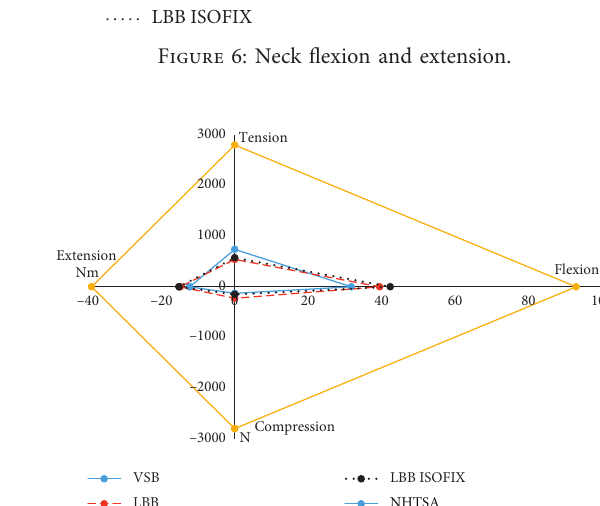
Figure 6: Neck flexion and extension.